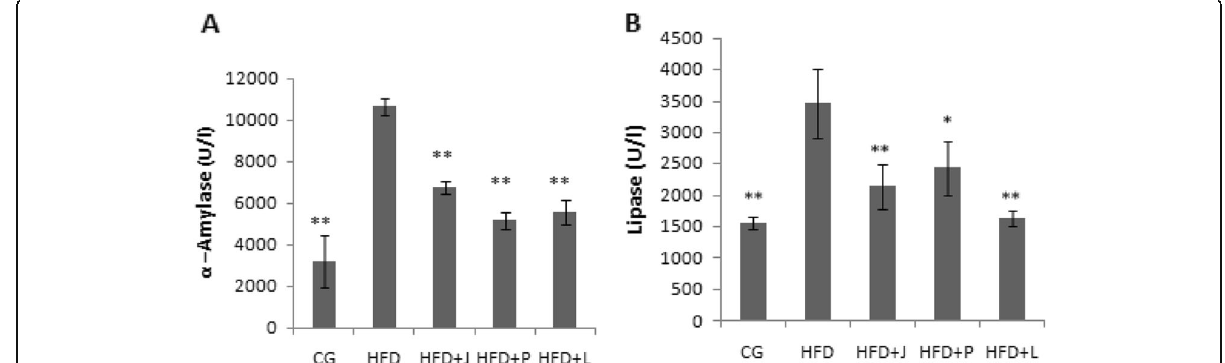
Fig. 3 Effect of pomegranate extracts administration on serum amylase ( a ) and lipase ( b ) levels. Results are shown as the mean ± SE ( n = 6). * p <